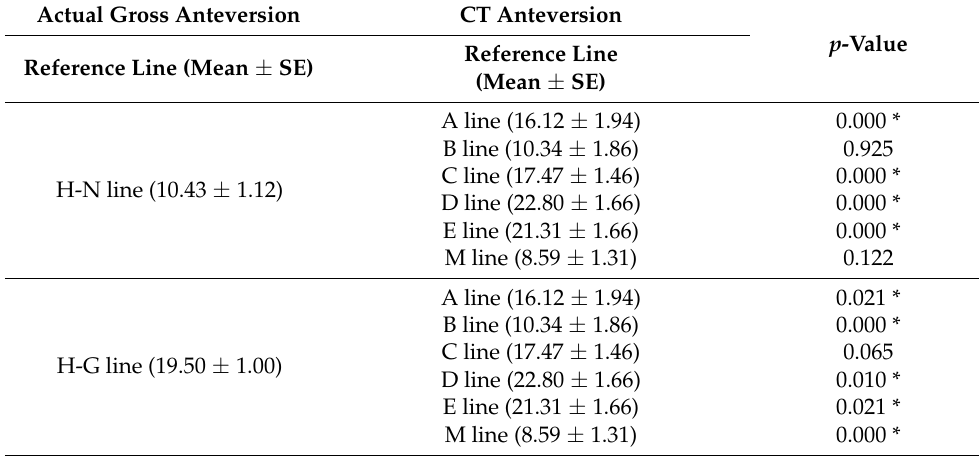
Table 2. Consistency between digital photographic techniques and CT